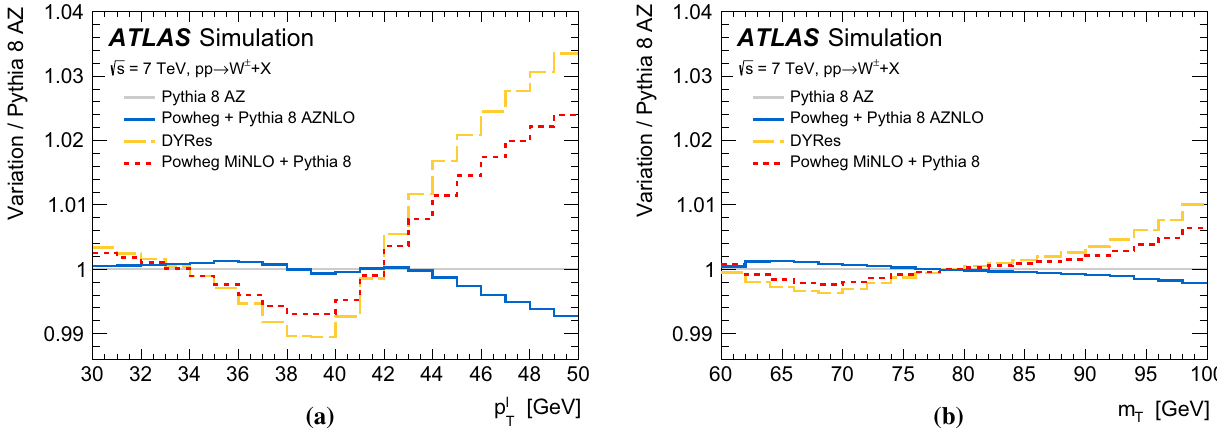
Fig. 2 Ratios of the reconstruction-level a p (cid:7) and b m T normalised distributions obtained using Powheg+Pythia 8 AZNLO, DYRes and Powheg T MiNLO+Pythia 8 to the baseline normalised distributions obtained using Pythia 8 AZ